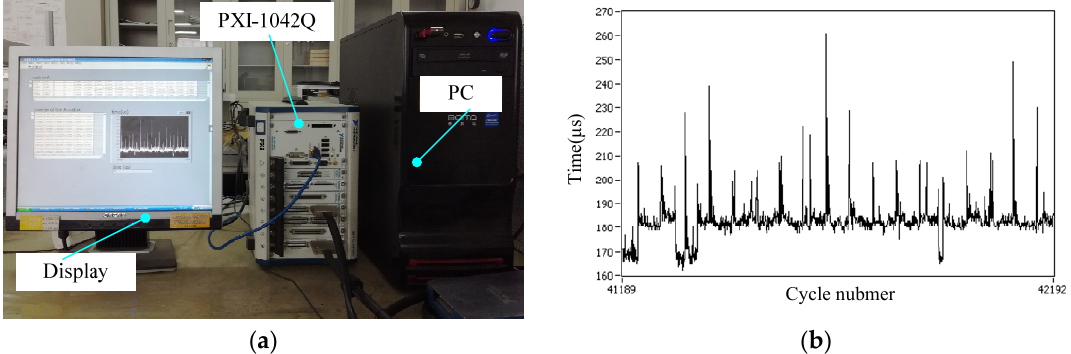
Figure 7. Program running time analysis. ( a ) Real-time control platform based on NI PXI-1042Q; ( b ) Results of the program running time.